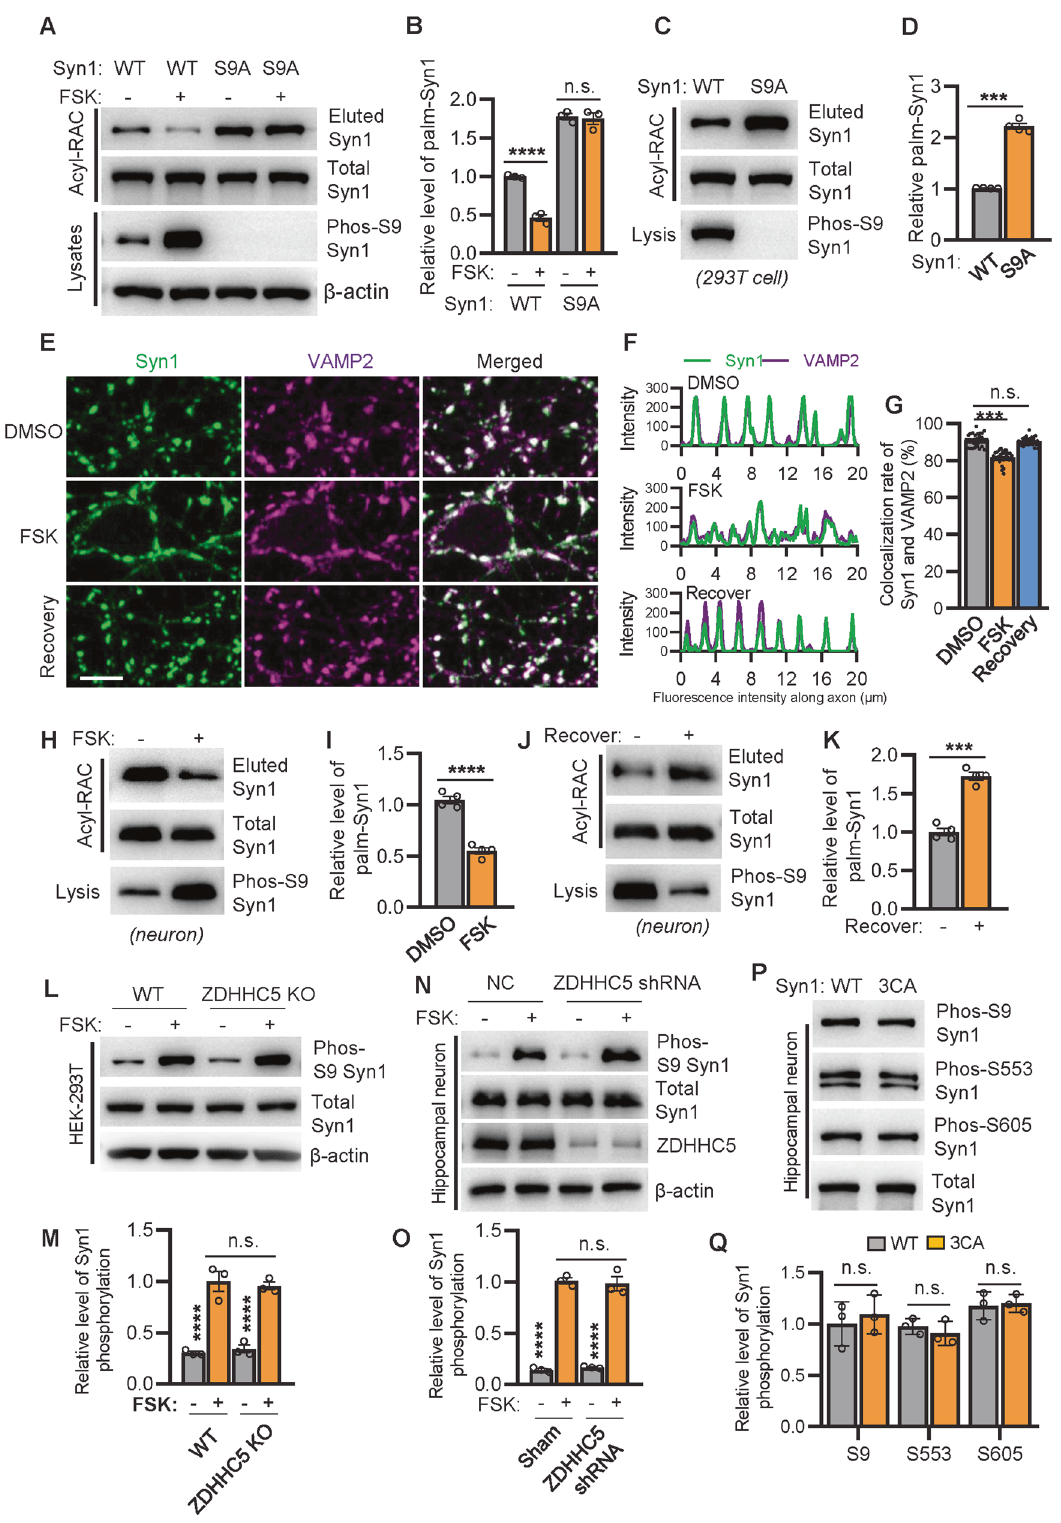
S8A – C) and is involved in SV recycling at the presynapse [43]; however, the loss of PPT1 [19] does not detectably alter palm-Syn1 in vivo (Fig. S8H). Interestingly, ABHD17a/b/c show redundant functions [44, 45] catalyzing Syn1 depalmitoylation in vitro (Fig. S9D, E). Our results showed that ABHD17c, but not ABHD17b,